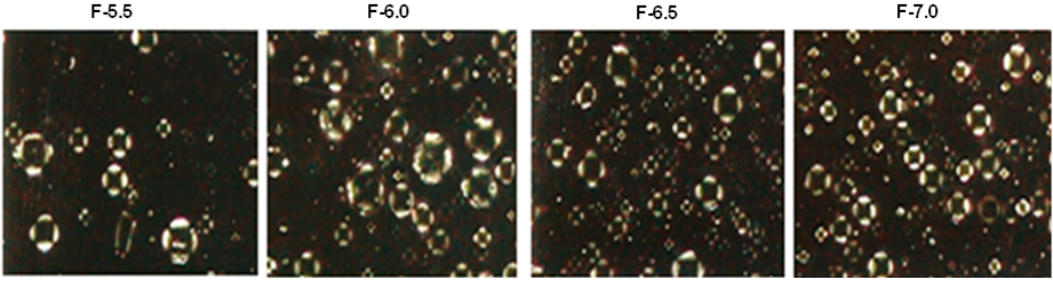
Figure 3. Polarized light photomicrographs (200×) of the formulations after 24 h. Table 2. Details of concentrations (% w / w ) of derivatives of formula 36 (after 36 III): surfactant–oils (7.5:2.5 sunflower–mineral oil)-purified